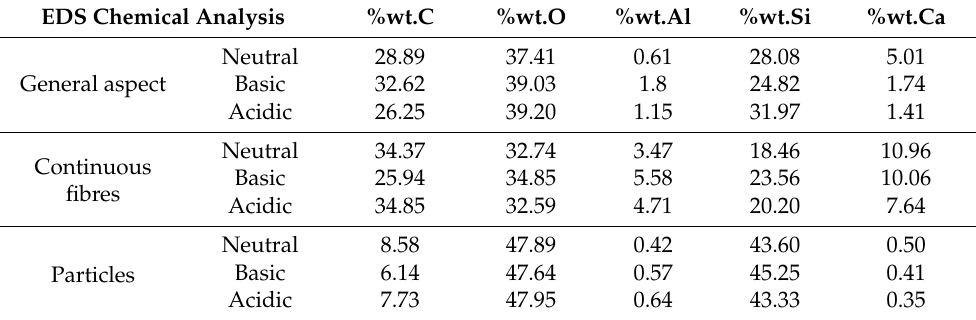
Table 5. EDS chemical analysis.